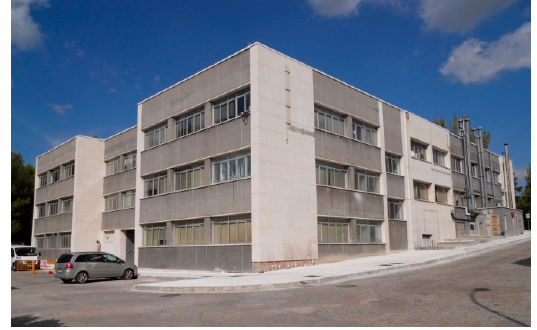
Figure 1. Southwest view of the building before the retrofit.